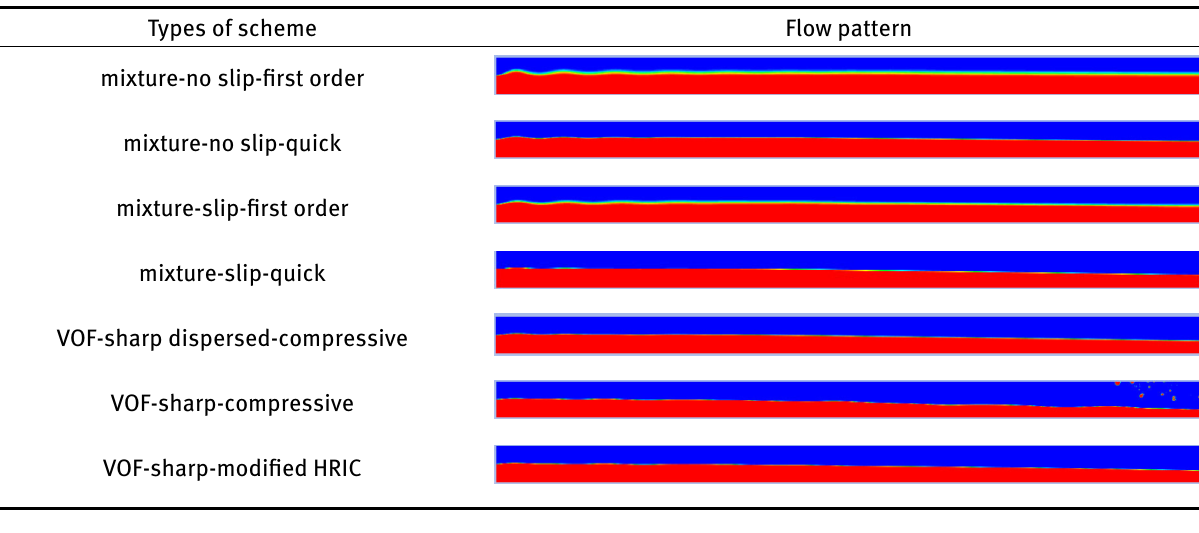
Table 10: Inlet the kerosene above the water for two-phase flow pattern, (L = 2 m, H = 7.5 cm), mesh (780,000) Types of